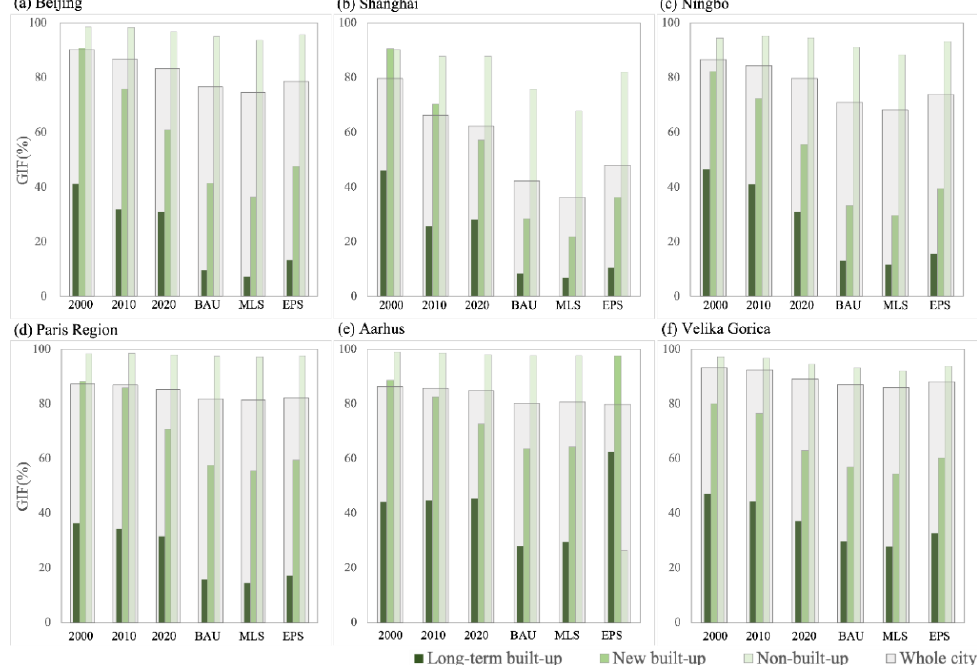
Figure 6. GIF in different urban development phases (long-term built-up, new built-up, and non- built-up) of each city from 2000 to 2030 and under the three BAU, MLS, and EPS scenarios for 2030.